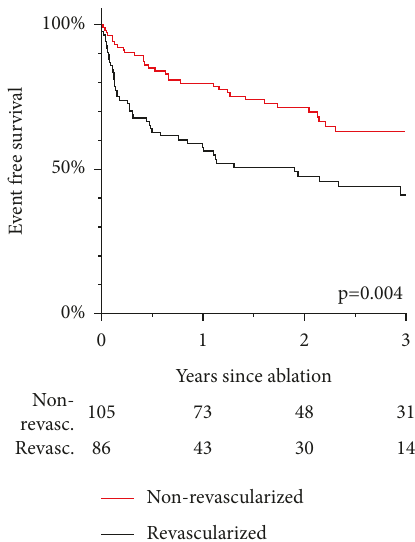
Figure 4: Recurrence of VTin revascularized vs. nonrevascularized